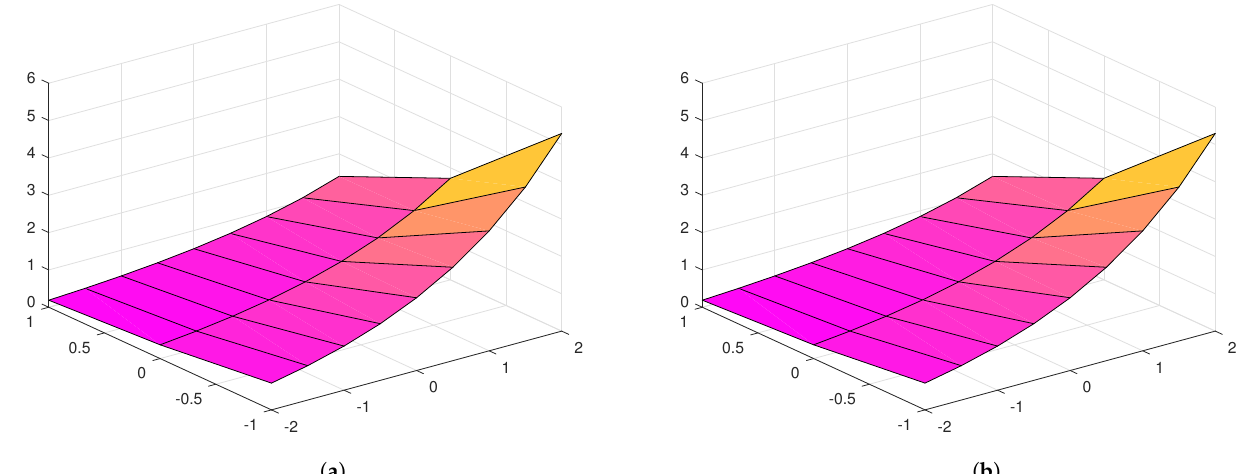
Figure 2. ( a ) Exact plot of example 1. ( b ) Comparison between approximate solution by SDM and VITM plot of example 1 at γ = 1.